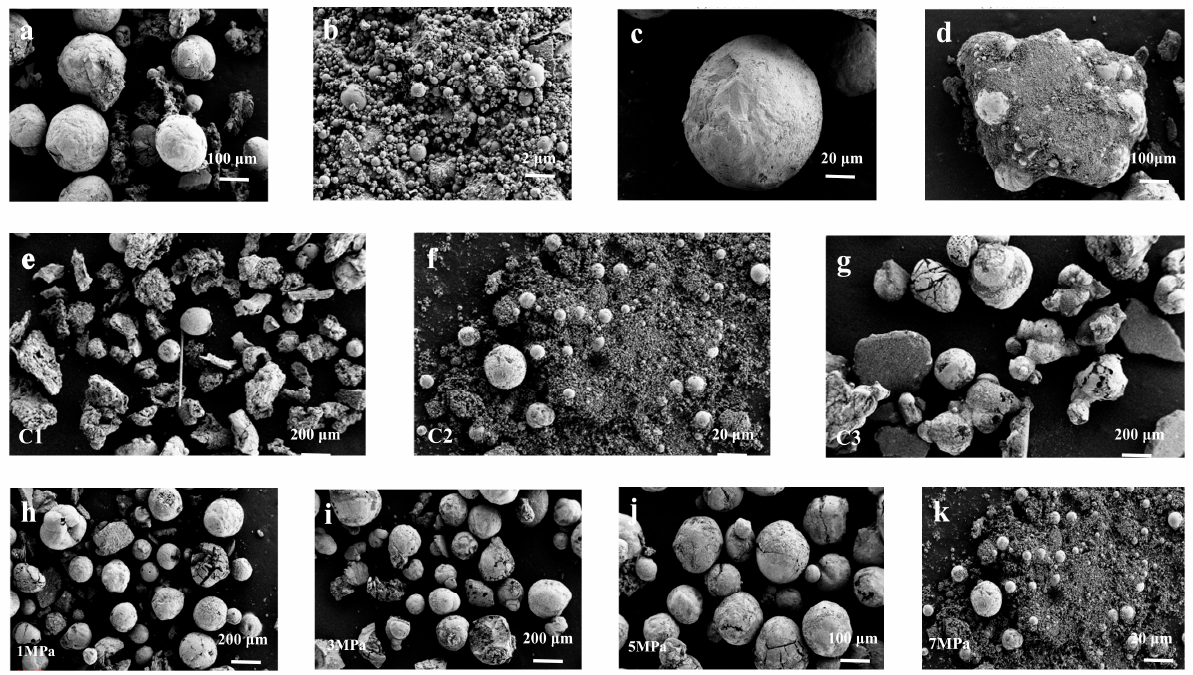
Figure 4. SEM images of the CCPs of three propellants: ( a – d ) Typical morphology of CCPs for C1 propellent; ( e – g ) C1, C2, C3 propellant microstructure of CCPs; ( h – k ) Four different pressure C2 propellant microstructures of CCPs.